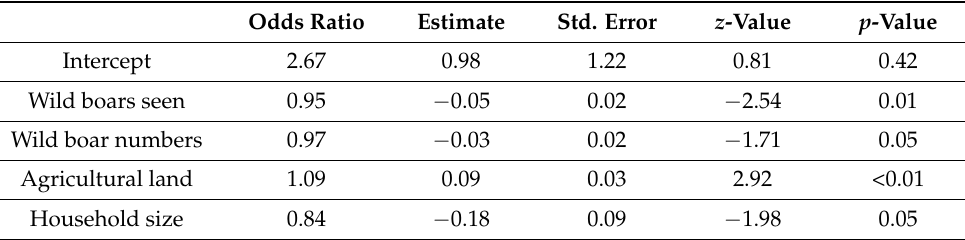
Table 9. The effects of the significant socio-economic factors on the attitudes of locals towards wild boars. The estimate is the GLM-based effects translated by the logs as odds ratio (standard error). The significance of each level compared to another level (called reference level) is presented by the p -values, which are further supported by the z